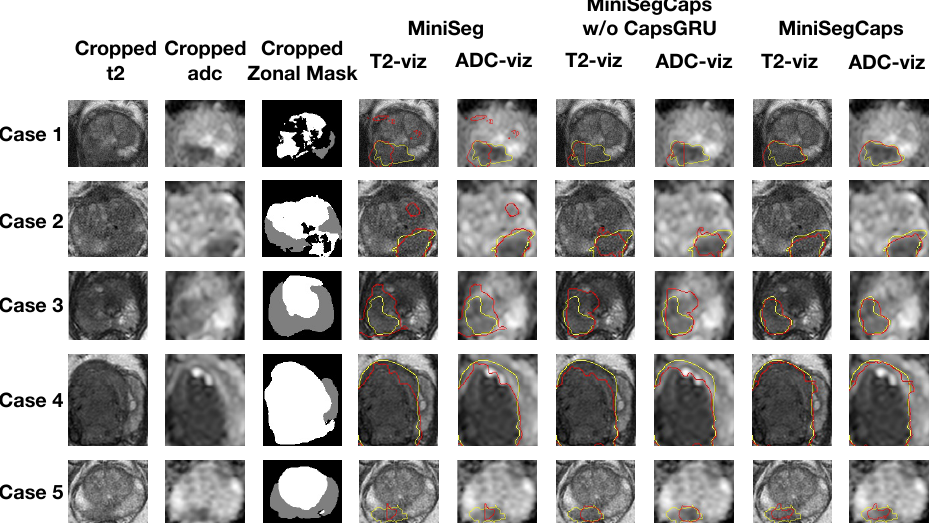
Figure 4. Visualization of lesion segmentation results among different cases. The yellow contour is the ground truth, and the red contours are from the deep learning